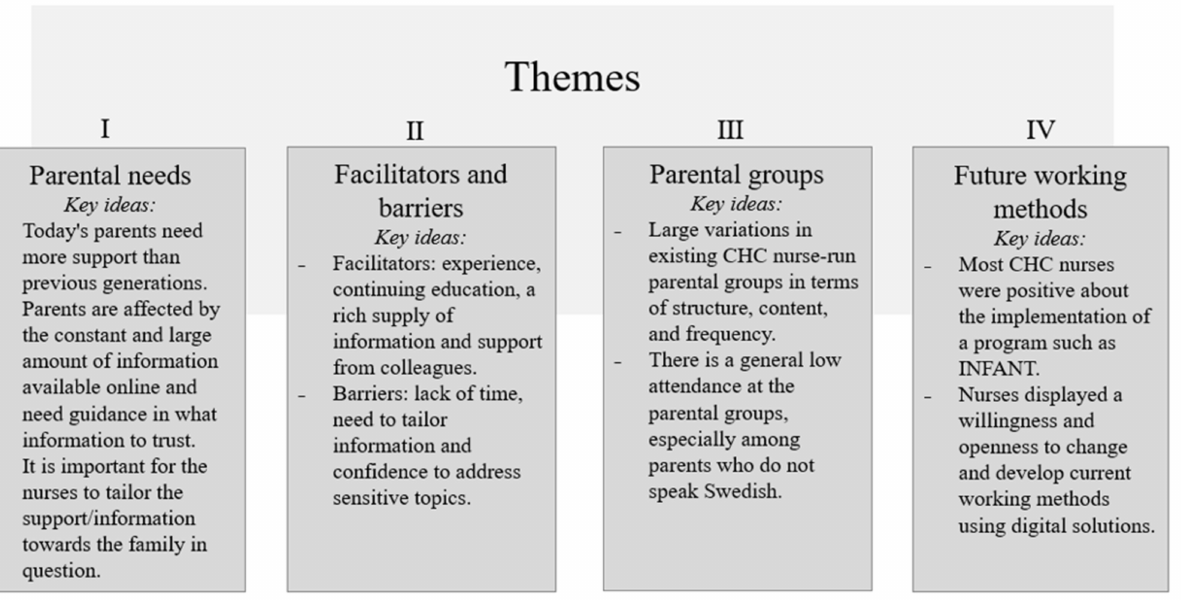
Figure 1. Themes and key ideas generated in the thematic